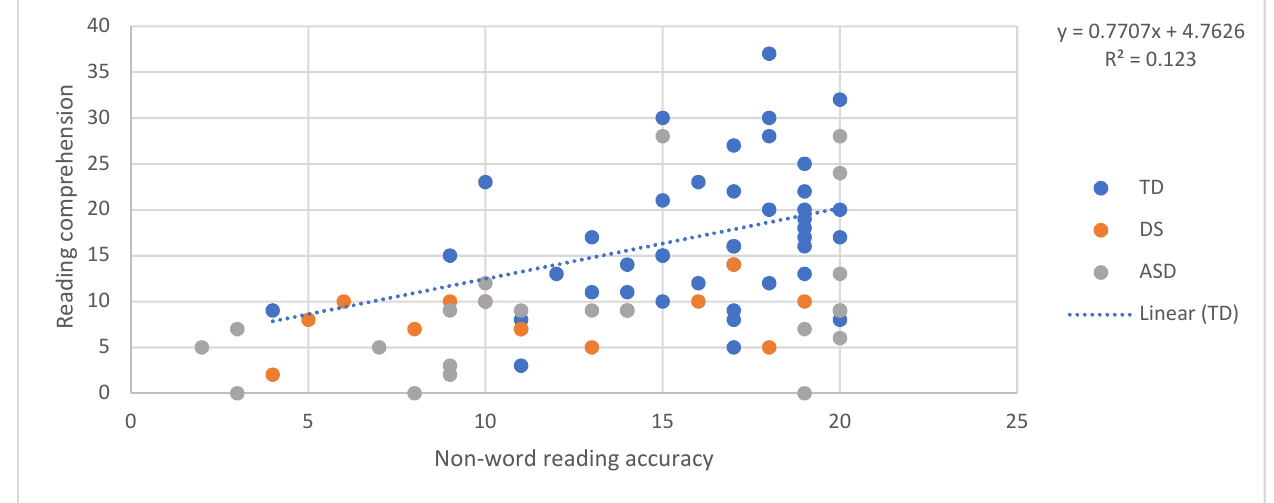
Figure 1. Word reading accuracy predicting reading comprehension.